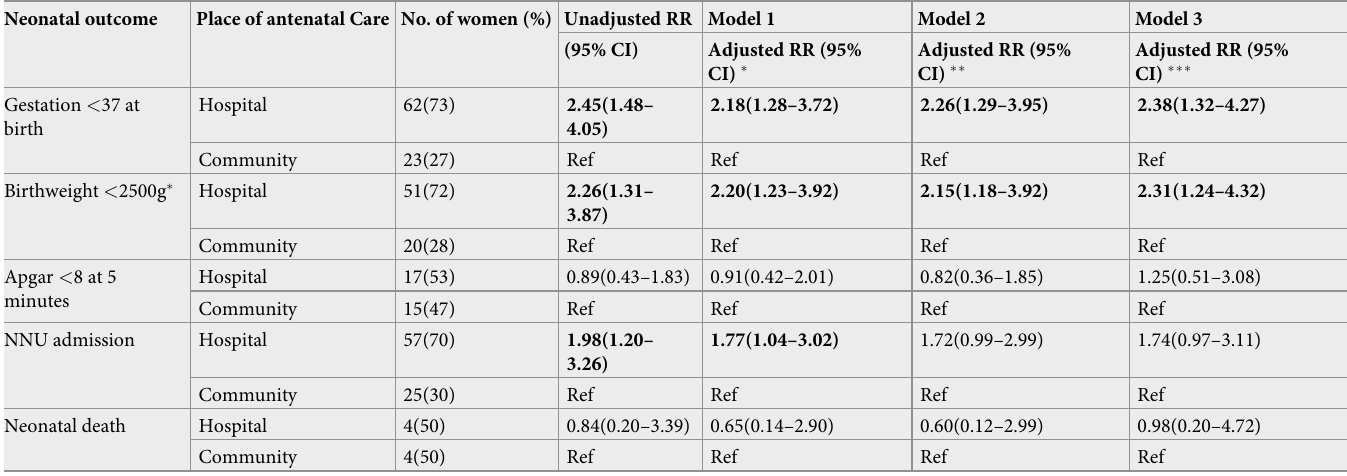
� Model 1: Adjusted for demographics: ethnicity, age, parity, IMD score, social risk and medical risk factors at booking and onset of labour. �� Model 2: Model 1 plus adjusted for model of care. ��� Model 3: Model 2 plus Adjusted for service provider attended.